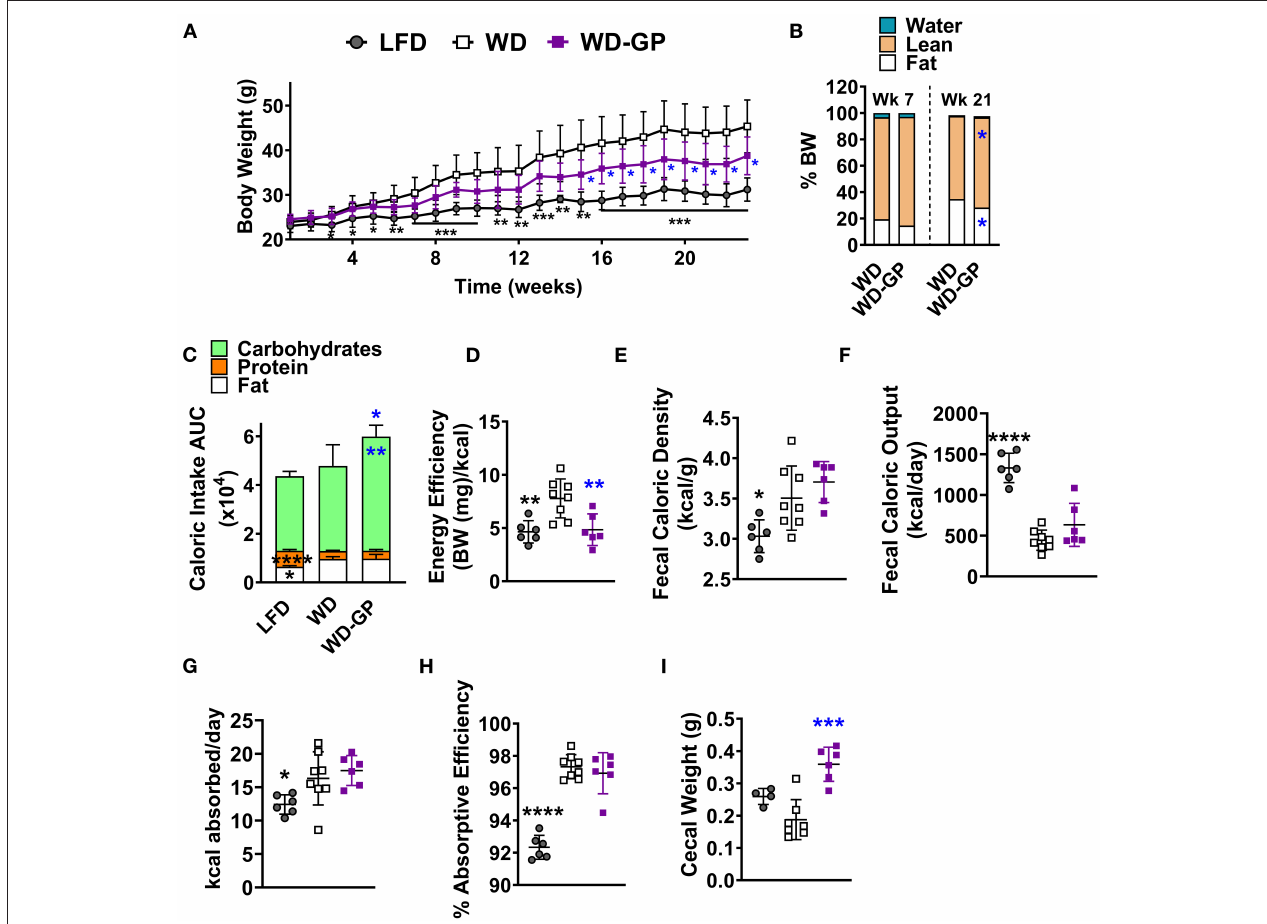
FIGURE 1 | GPs improved body composition and decreased energy efficiency despite greater consumption of calories from carbohydrates. (A) Mean weekly body weight for each diet-group ( n = 6–8). (B) Mean body composition, i.e., water, lean, and fat mass as % of body weight (BW), after 7 and 21 weeks of the diet-intervention ( n = 6–8). (C) Mean area under the curve (AUC) of caloric intake from macronutrients from both food and sucrose water over the diet-intervention period ( n = 6–8/group). Raw data from which AUCs of caloric intake were obtained are shown in Supplementary Figures 2B–E . (D) Energy efficiency (mg of body weight gained per kcal consumed) over the diet-intervention. (E) Fecal caloric density per gram of feces (wet wt.) and (F) total caloric output from feces per day, during week 17 of diet-intervention. (G) Calories absorbed per day (calories consumed—calories excreted) and (H) absorptive efficiency denotes the percentage of calories absorbed by intestine from calories consumed from food and sucrose water at week 17 of diet-intervention. (I) Cecal weight with contents on day of euthanasia (week 24 of diet-intervention). Data are presented as mean ± SD. For (B) significant difference between diet groups was determined by an unpaired, two-tailed, t -test with Welch’s correction and for all other panels significant differences were determined by one-way ANOVA followed by Dunnett’s multiple comparisons test with WD group as the control; black colored asterisks indicate statistical significance between the LFD vs. WD group and blue-colored asterisks indicate statistical significance between the WD vs. WD-GP group: * p < 0.05, ** p < 0.01, *** p < 0.001, **** p <